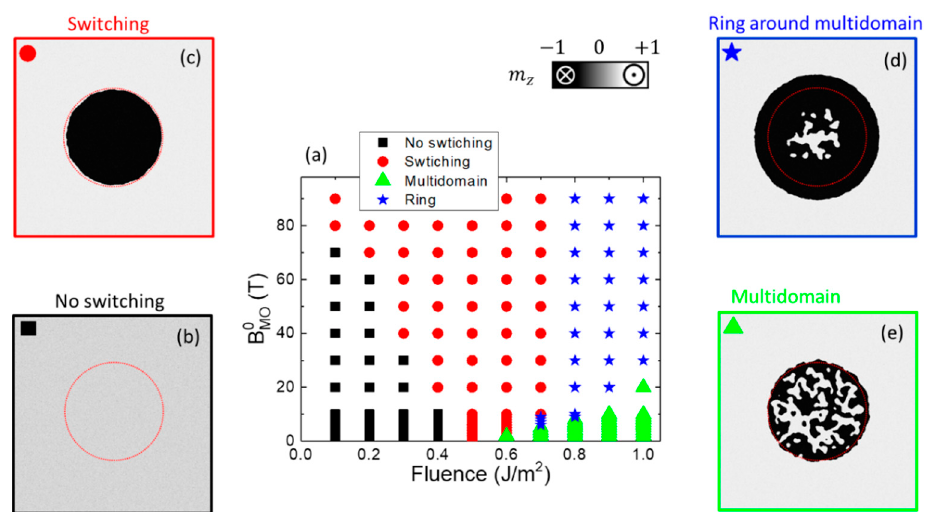
Figure 3. ( a ) Phase diagram of final states as a function of the fluence ( F ) and the maximum amplitude of the magneto-optical field ( 𝐵 (cid:3014)(cid:3016)(cid:2868) ) starting from a uniform up magnetization ( m ↑ ). The results were obtained by applying a train of laser pulses with left-handed helicity ( σ − ). Snapshots ( b – e ) represent typical final possible states. The black squares correspond to no-inversion combinations ( b ). The red dots correspond to cases where the local magnetization under the laser beam reverses its initial state ( c ). The green triangles correspond to a multi-domain final state ( d ), and the blue stars depict combinations of where the central area below the laser beam becomes demagnetized with an inverted ring around a multi-domain pattern ( e